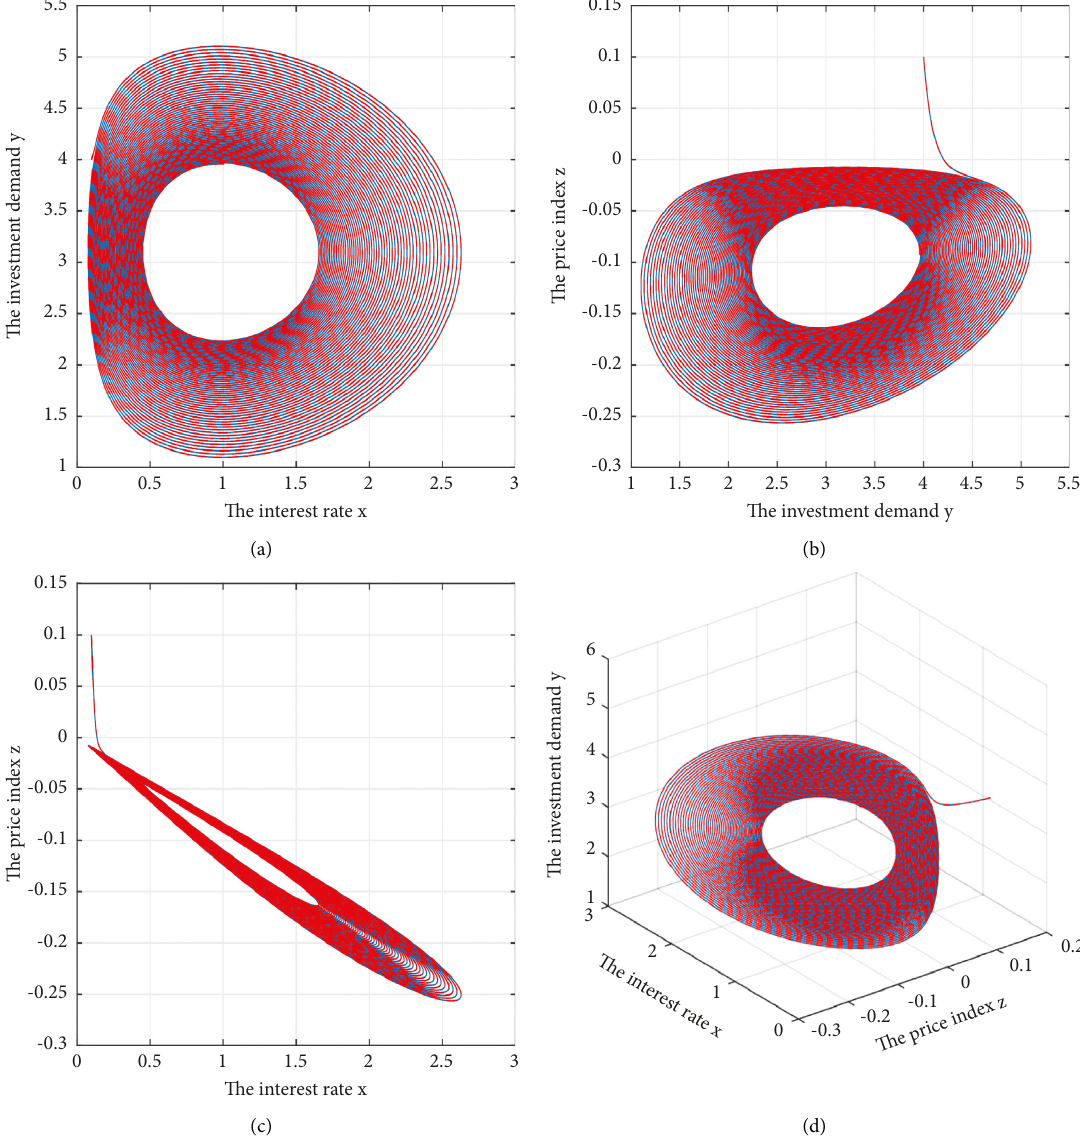
Figure 10: The phase portrait of the proposed model where (a) the demand of investment versus the rate of investment, (b) the index of price versus the demand of investment, (c) the index of price versus the rate of investment, and (d) the chaotic behaviour of the system with the input parameters a � 3 . 0 , b � 0 . 01, and c � 10 to identify the influence of these input parameters on the chaos of the